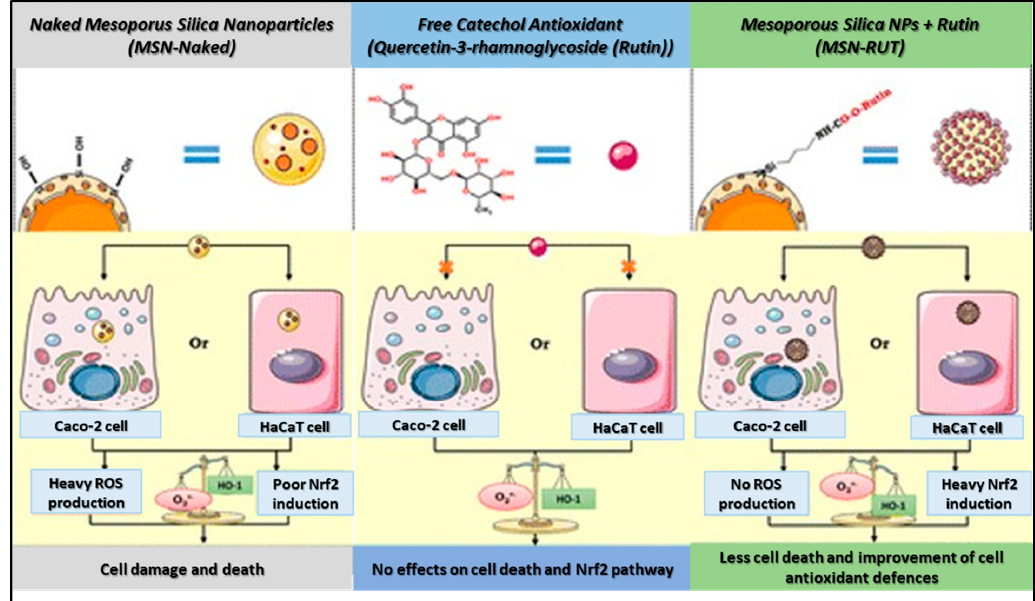
Figure 2. Influence of naked MSNs, free catechol antioxidant (Rutin), and MSNs-RUT on ROS production or Nrf2 induction and consequent cell death. Adapted from Ref. [43] with permission from © 2016 American Chemical Society.